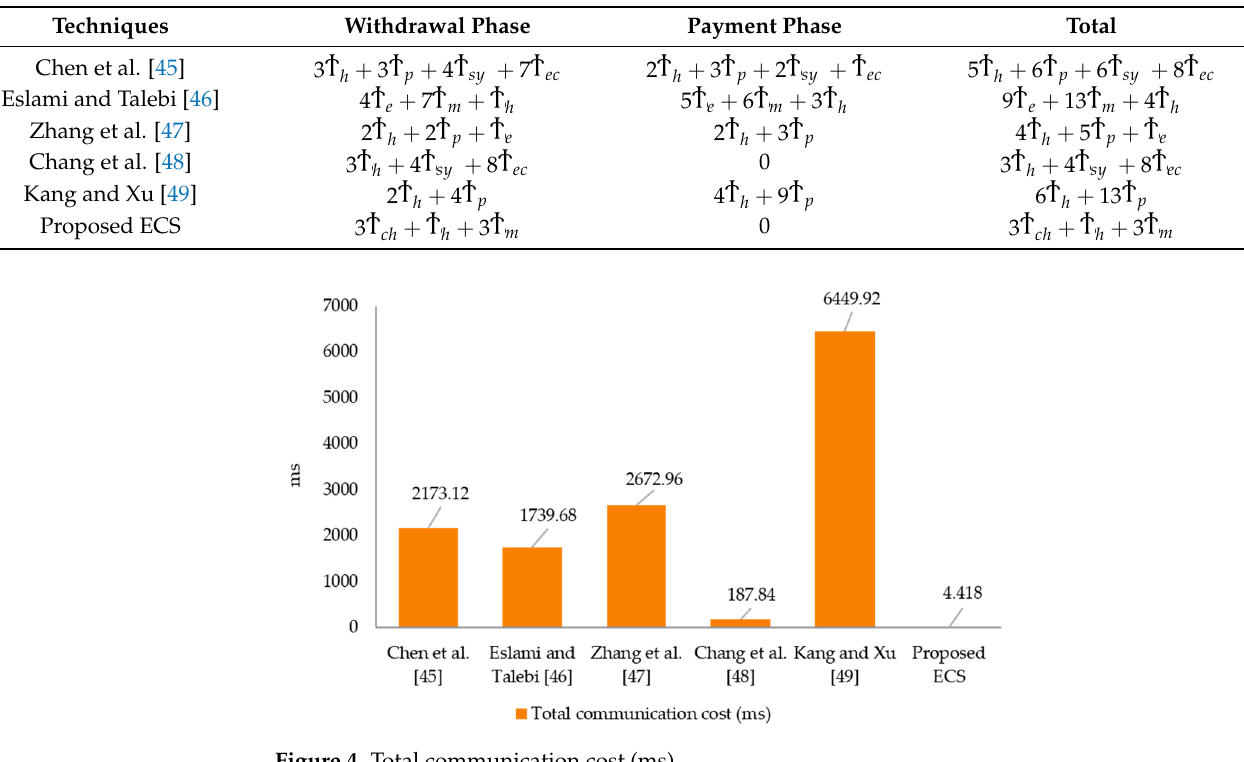
Table 2. Assessments of important operations with reverence techniques.